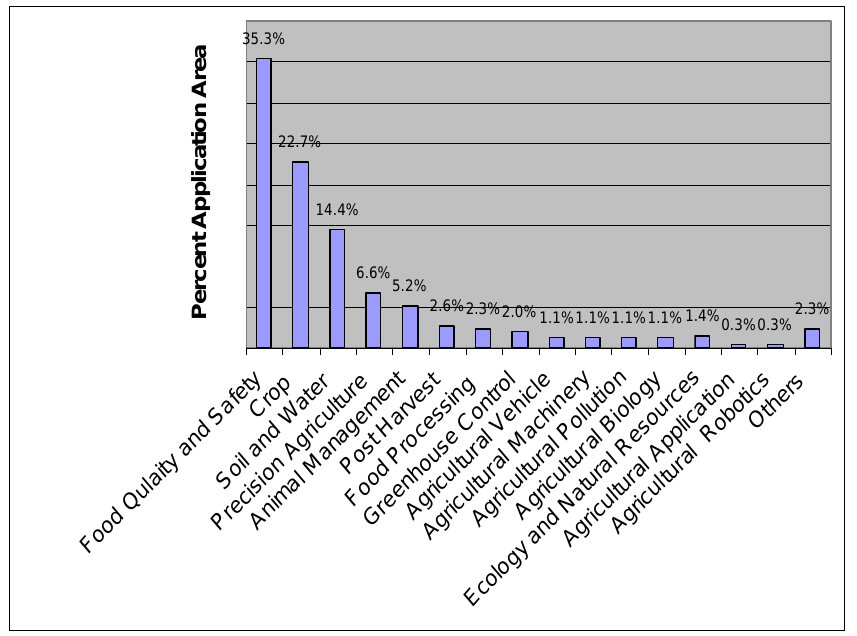
Figure 10. Application area distribution of ANNs in agricultural and biological engineering.